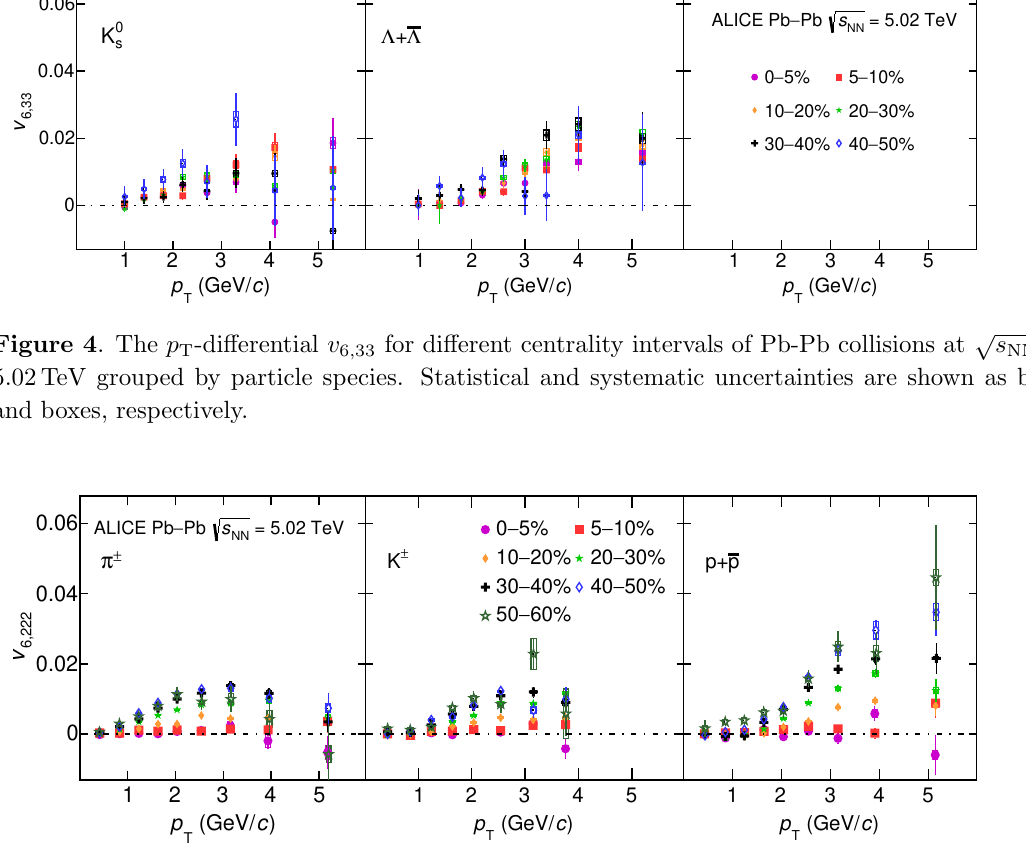
Figure 5 . The p T -di(cid:11)erential v 6 ; 222 for di(cid:11)erent centrality intervals of Pb-Pb collisions at 5 : 02 TeV grouped by particle species. Statistical and systematic uncertainties are shown as bars and boxes,